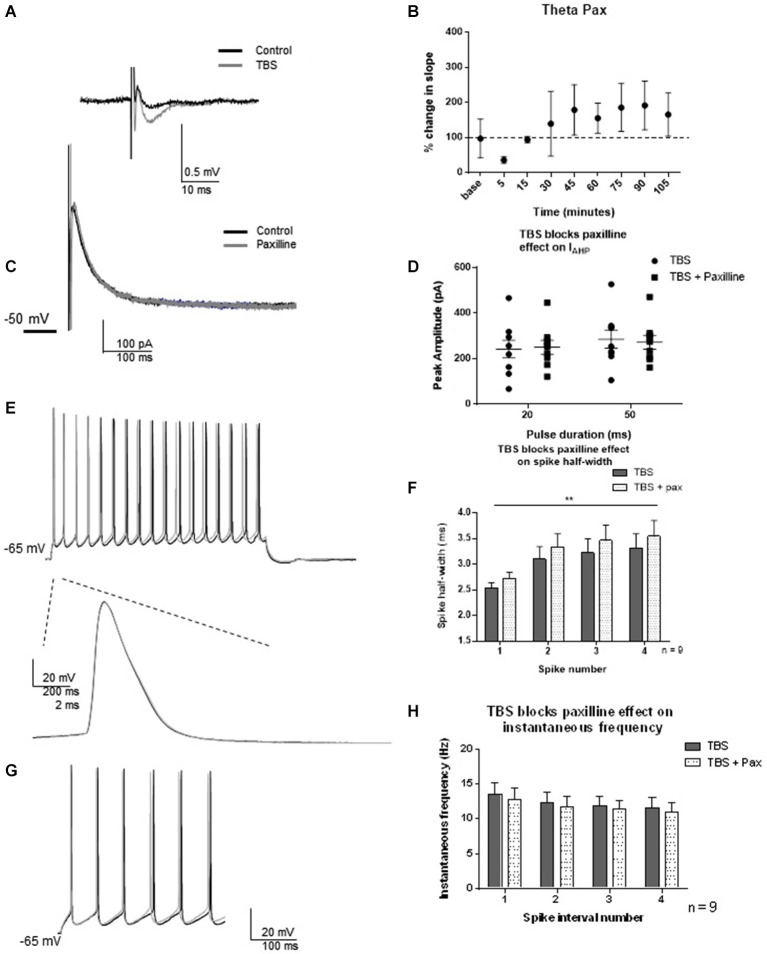
TBS occluded the effect of blockade of BK channels with paxilline 2–3 h after TBS. (A) Example of fEPSP in control and after TBS. (B) Bar graph showing the effect of TBS on fEPSP amplitude. TBS significantly increased fEPSP amplitude. (C) Example of peak IAHP recorded 2–3 h following TBS in paxilline (gray) compared to control (black). (D) Summary scatter plot showing that paxilline (closed squares) had no effect on IAHP amplitude 2–3 h following TBS compared to control (closed circles) (E) Example of voltage response to 100 pA recorded 2 h after TBS (black) and in the presence of paxilline (gray). Example of first spike in that train control (black) and paxilline (gray). (F) Summary bar graph showing the lack of effect of paxilline following TBS. As shown previously, spike half-width increased across the first four spikes (**p < 0.0001), and paxilline application (gray dippled) had no significant change compared to control after TBS (gray). (G). Example of instantaneous firing frequency recorded 2–3 h after TBS (black) and after TBS in paxilline (gray). Paxilline application had no significant effect on instantaneous frequency (dippled) after TBS compared to control (gray). (H). Summary bar graph showing the results from the first five spikes. Data are reported as mean ± SEM.